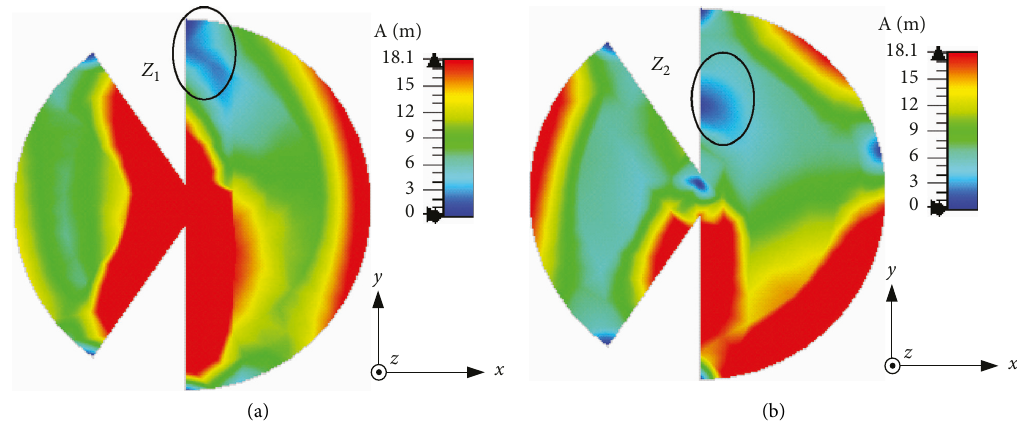
Figure 5: Current difference distribution between (a) J